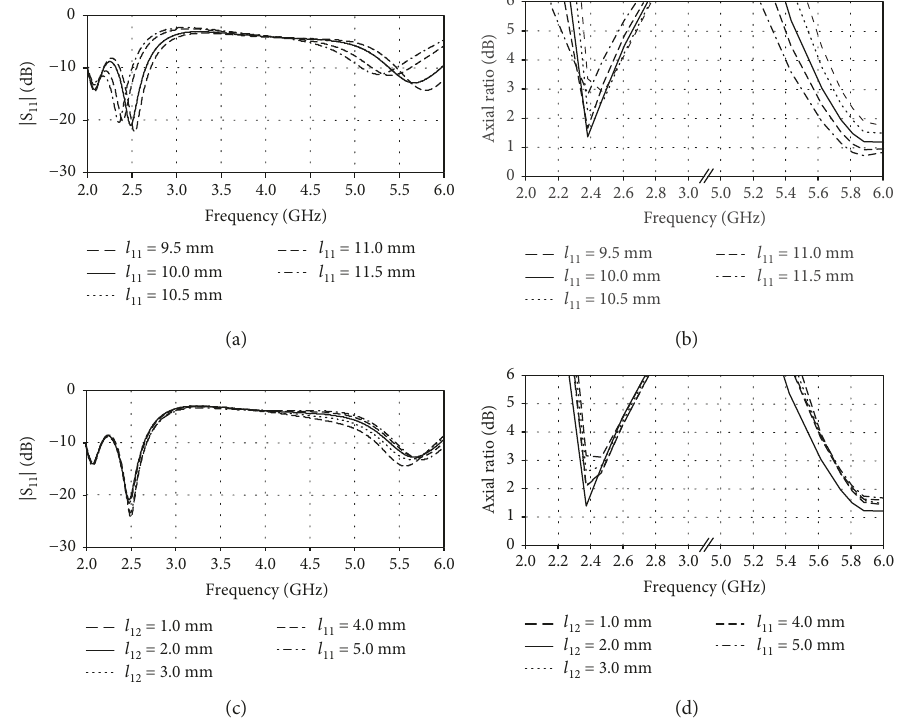
l 11 when l1 is varied, (b) axial ratio when